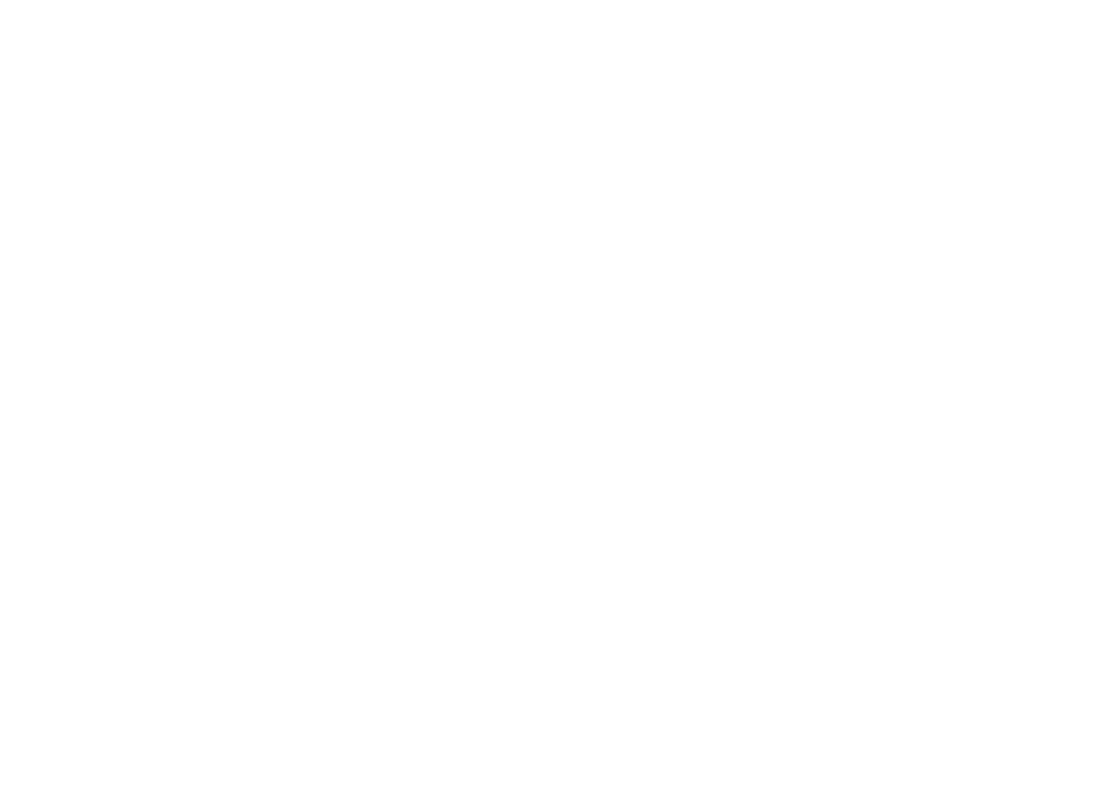
Figure 10. The transmittance spectra of the one-dimensional photonic crystal containing HMM at different incident angles for TE